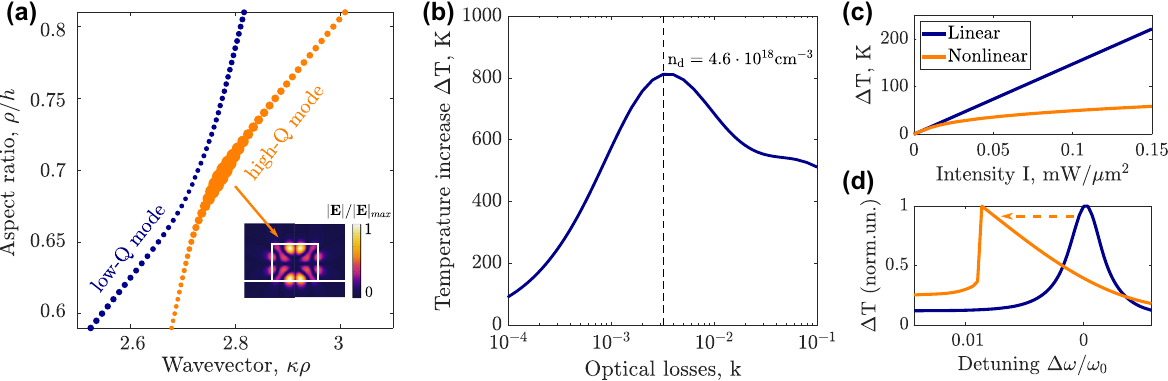
Figure 3: Linear optimization of optical resonator parameters. (a) The cylinder eigenmodes positions depending on the dimensionless wavevector 𝜅𝜌 = 2 𝜋𝜌 ∕ 𝜆 , where 𝜆 – mode free-space wavelength, 𝜌 – cylinder radius, and on the dimensionless size parameter 𝜌 ∕ h , where h is the cylinder height. The size of the dots is proportional to the eigenmode quality factor. The inset shows a normalized electric field for quasi-BIC mode with quality factor Q = 615. (b) Simulated temperature increase in a cylinder with quasi-BIC mode as the function of the imaginary part of refractive index k responsible for optical losses of the system. Dashed line shows the optimal value of the losses which corresponds to the concentration of dopants n d = 4.6 ⋅ 10 18 cm − 3 . (c) Comparison of linear (without thermorefraction) and nonlinear (with thermorefraction) regimes of heating the nanoparticle for zero detuning 𝛿𝜔 = 0. (d) Spectral shift of heating characteristic from linear (orange) to nonlinear (blue) one for thermorefractive system. The incident intensity is I = 0.275 mW ∕μ m 2